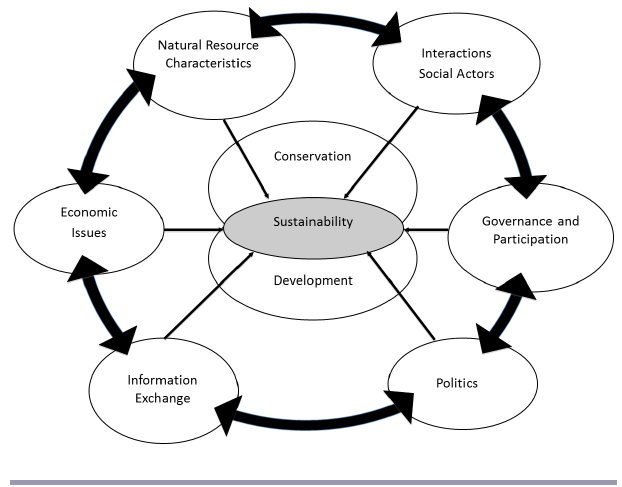
Fig. 1 . Conservation and development conceptual